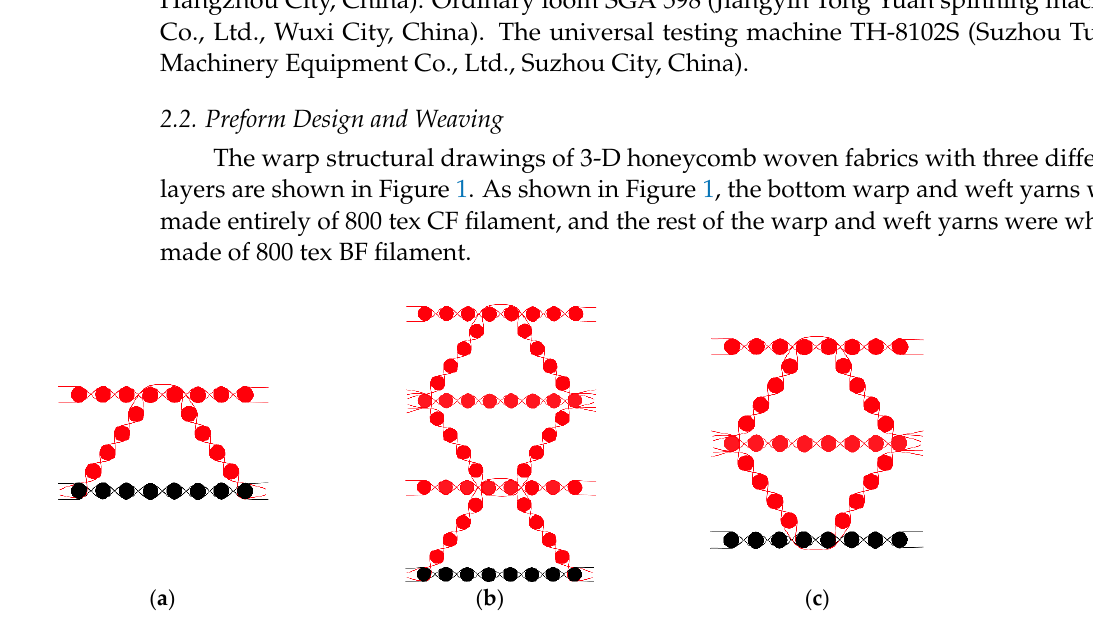
Figure 1. ( a ) Warp structural drawings of 7.5 mm 3D honeycomb woven fabric; ( b ) warp structural drawings of 15 mm 3D honeycomb woven fabric; ( c ) warp structural drawings of 22.5 mm 3D honeycomb woven fabric. The chain drafts of 3-D honeycomb woven fabrics with three different thicknesses were drawn up according to the warp structural drawings, and they are shown in Figure 2. The weaving parameters of 3-D honeycomb woven fabrics are shown in Table 1.